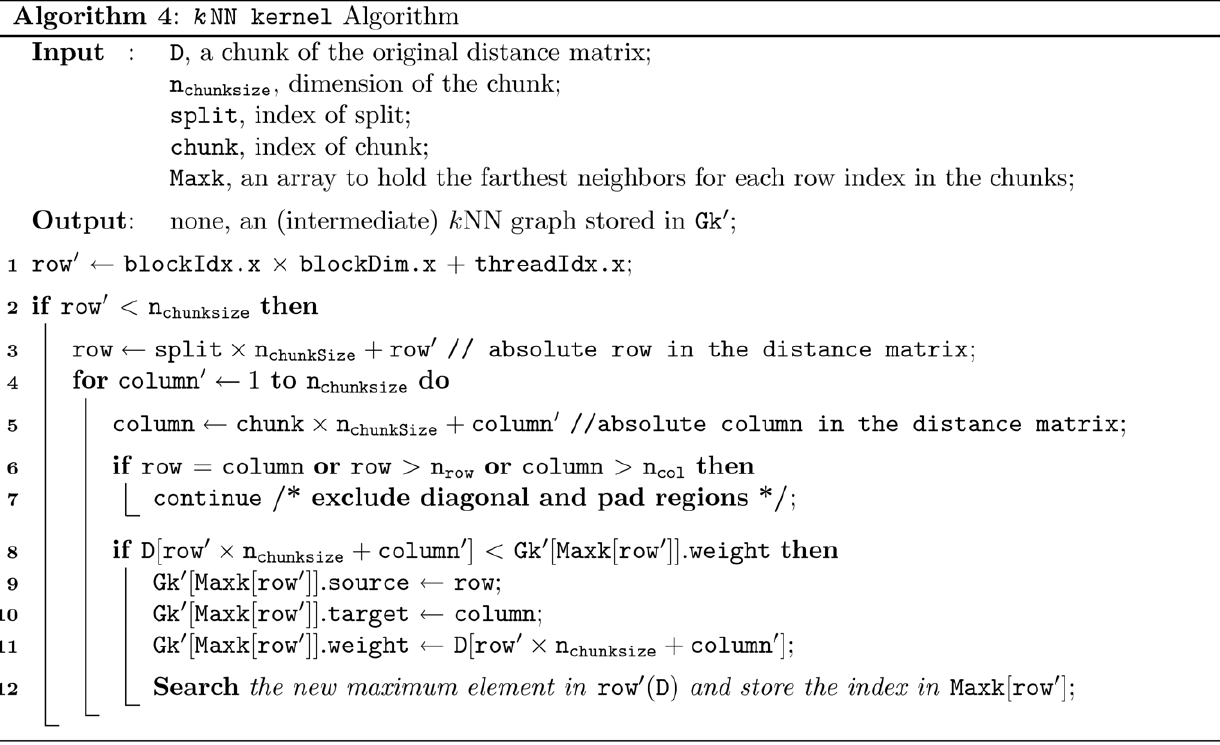
Figure 8. Pseudocode for the k NN Kernel. The kNN kernel algorithm utilizes one dimensional block and thread structure. Each thread works on a row of the chunk and identifies the k -nearest neighbors for each respective row index. Additionally, based on position of the chunk, it skips certain indices, e.g., the diagonal distance values (i.e., the distance from the point itself) and values that fall into the extra (padding) regions of the matrix. basic algorithm and the thread organization is adapted from